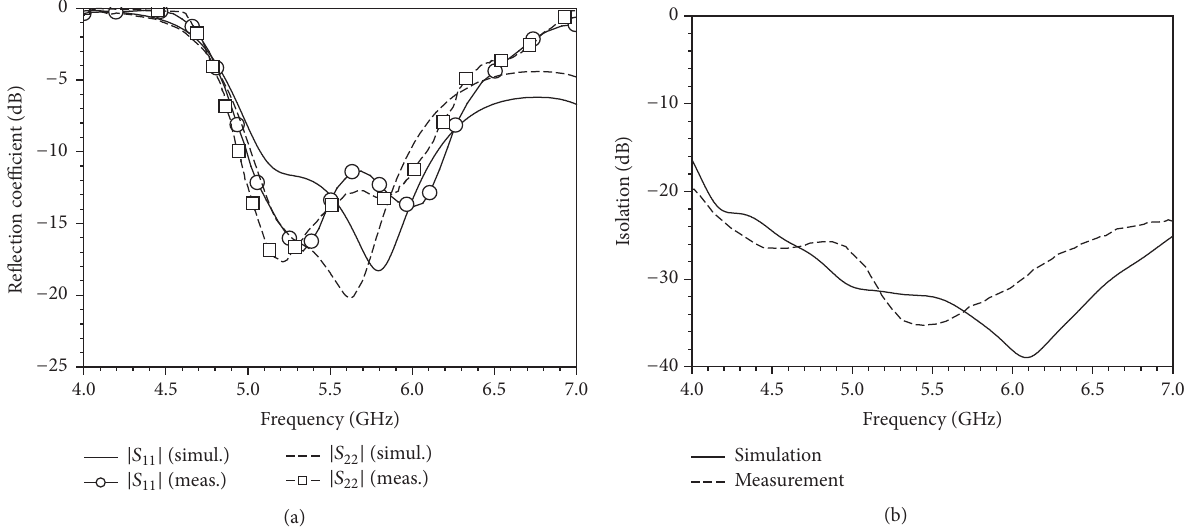
Figure 7: (a) Reflection and (b) isolation performance of the fabricated feed.